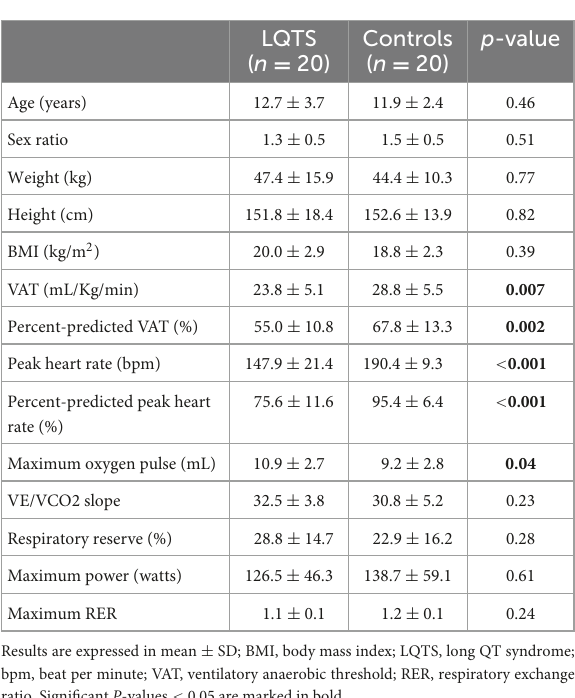
TABLE 1 Demographic data and CPET values between LQTS and control groups.